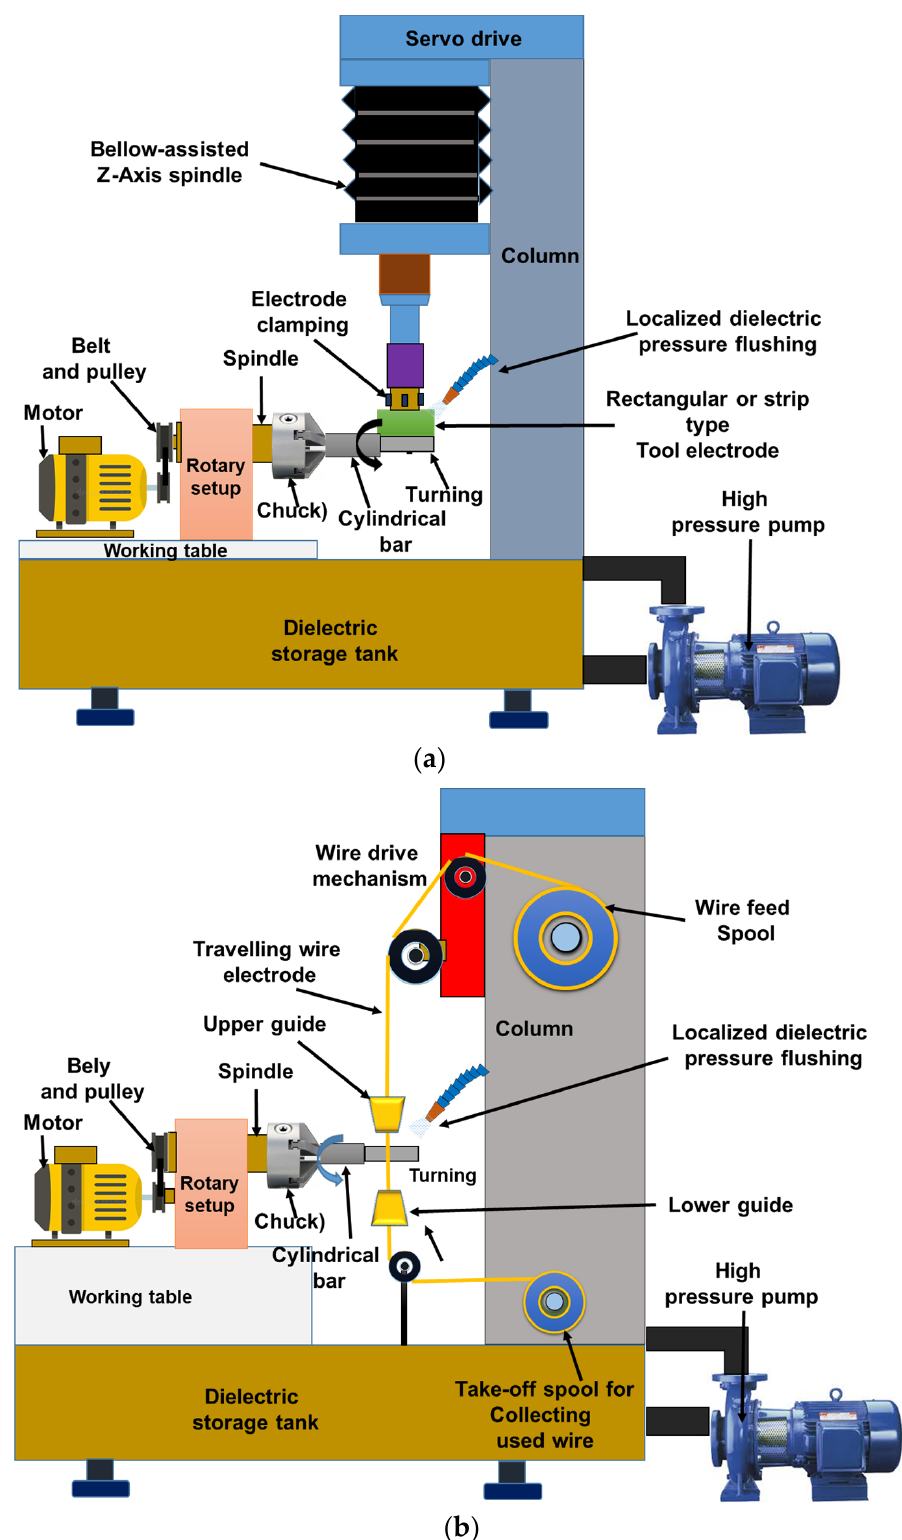
Figure 2. Schematic representation of wire-assisted thermoelectric-erosion based turning setup: ( a ) thermoelectric-erosion turning (TET) process; and ( b ) wire-assisted thermoelectric-erosion turning (WTET) process.